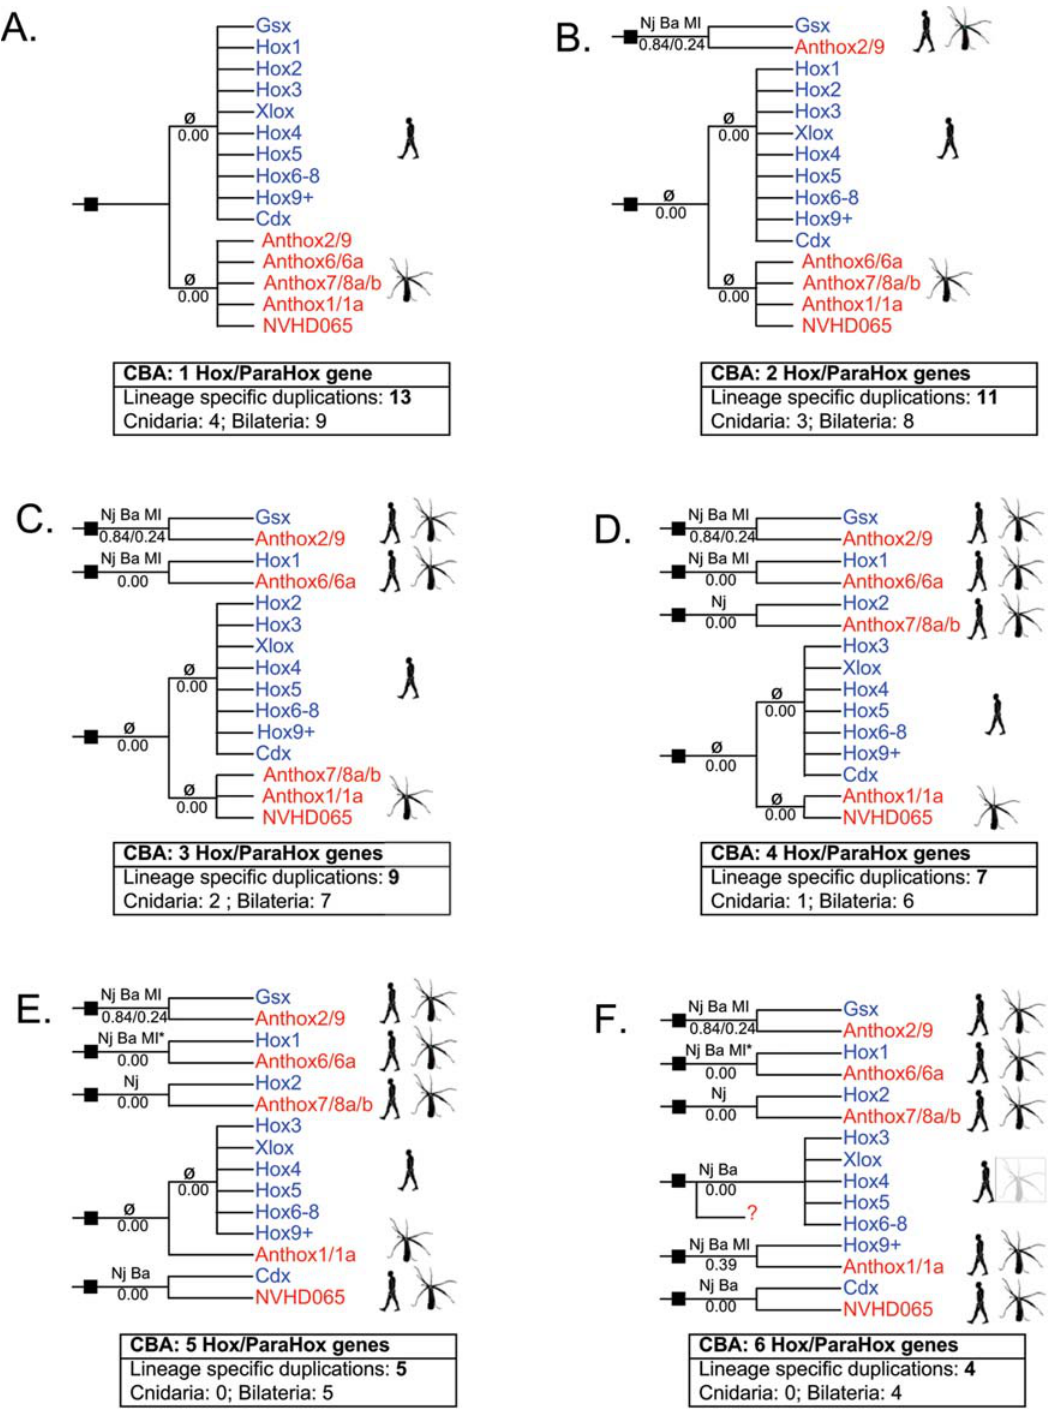
Figure 7. Hox/ParaHox evolutionary scenarios. The phylogenies drawn here depict six mutually exclusive scenarios regarding the evolution of the Hox and ParaHox genes. Ten distinct Hox and ParaHox lineages are thought to have been present in the ancestral bilaterian (Hox1, Hox2, Hox3, Hox4, Hox5, Hox6–8, Hox9 + , Cdx, Gsx, and Xlox). Five distinct Hox/ParaHox lineages are recognized for Nematostella . ( Nematostella homeodomains that tend to cluster together in the phylogenetic analyses are grouped together here: anthox1/1a; anthox2/9; anthox6/6a; anthox7/8a/8b.) Assuming no gene loss in the Cnidaria, then the existence of five Hox/ParaHox lineages in Nematostella implies that the cnidarian-bilaterian ancestor (CBA) could have possessed as few as one Hox/ParaHox gene (scenario A) or as many as five (scenario E). There is some indication that a central class Hox gene was lost in the Cnidaria [47], and that the CBA may have possessed six distinct Hox/ParaHox genes (scenario F). The ancestral Hox/ParaHox genes present in the CBA are indicated by solid squares. If a particular hypothetical clade is recovered on one or more of the phylogenetic analyses presented here, this is indicated above the relevant branch (NJ=neighbor-joining, Figure 2; Ba=Bayesian inference, Figure S1; ML=maximum- likelihood, Figure S2; w =none). Below each branch, the average statistical support is indicated (NJ-bootstrap proportion + Bayes-posterior probability + ML-boostrap proportion/3). Each scenario implies a different number of lineage-specific gene losses. doi:10.1371/journal.pone.0000153.g007 PLoS ONE |